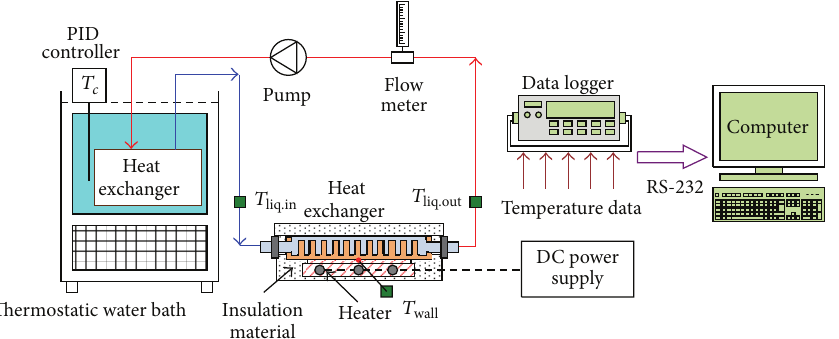
Figure 1: Layout of device in heat exchange experiment.